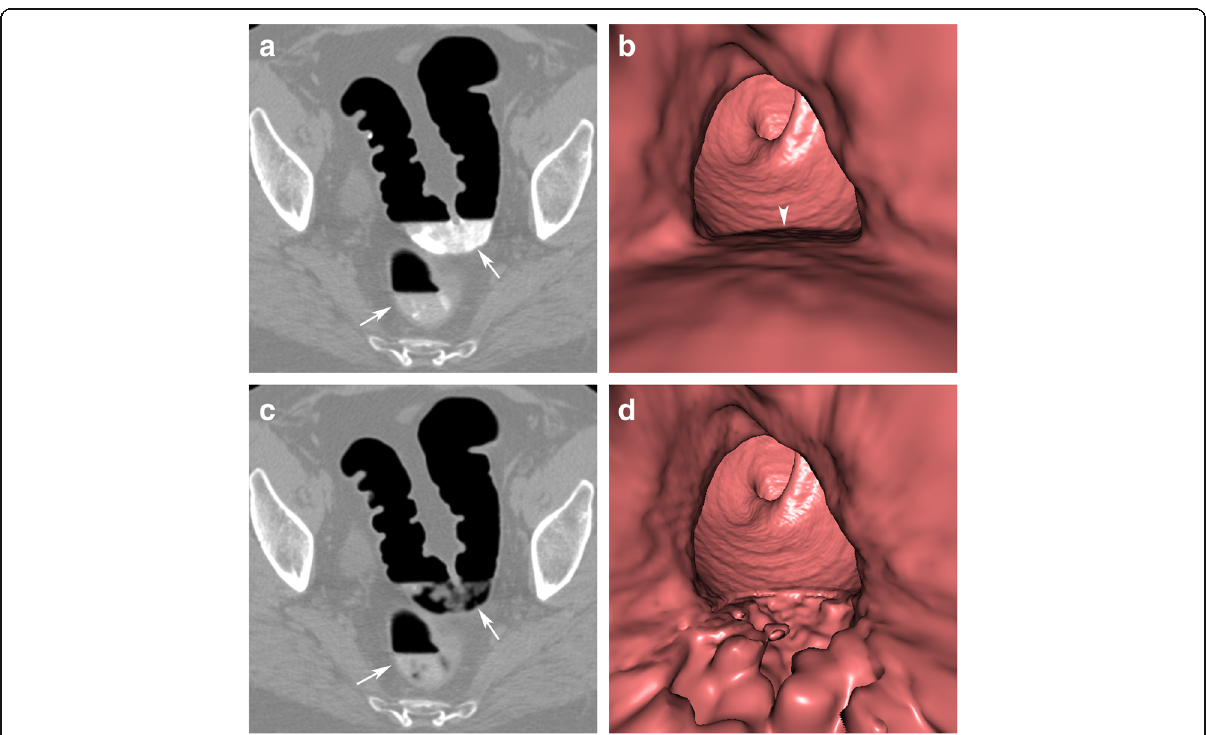
Fig. 2 Incomplete EC due to inhomogeneously tagged faecal residue. a Faecal residues are not adequately tagged, resulting in an inhomogeneous appearance on axial 2D images (arrows). b A horizontal fluid layer is seen endoluminally before EC (arrowhead). c After EC, only sufficiently tagged parts of the residue can be subtracted, while the other parts remain in the colon lumen (arrow). d This leads to a bizarre, irregular luminal filling defect on 3D endoluminal